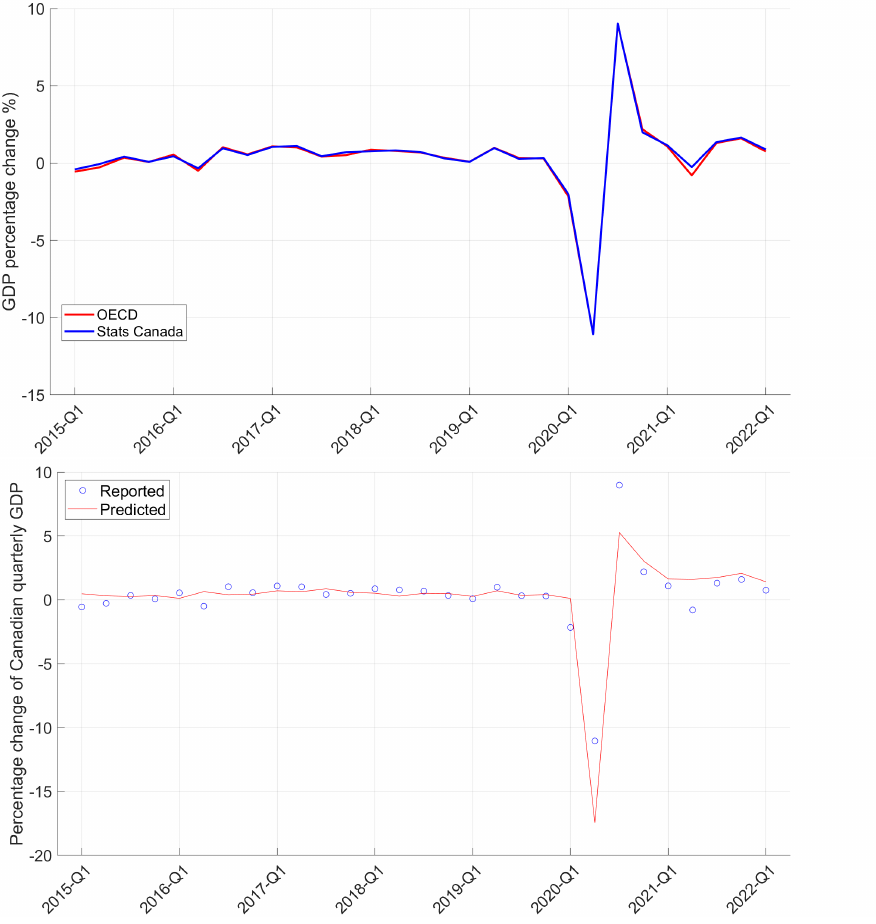
Figure 12. Comparison between quarterly changes in GDP from OECD and Stats Canada data ( top ) and between OECD data and predictions based on Okun’s law ( bottom